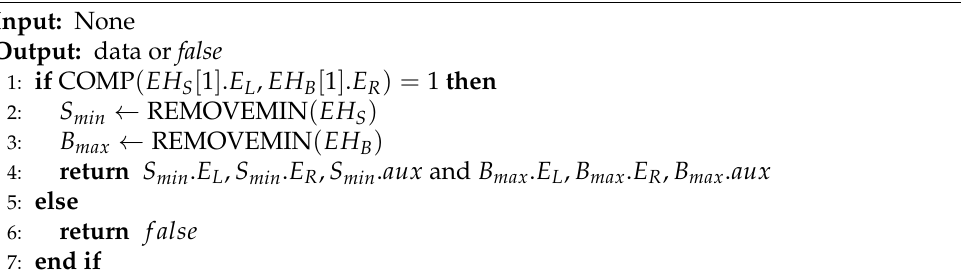
Algorithm 6 MATCHING procedure to check for possible match